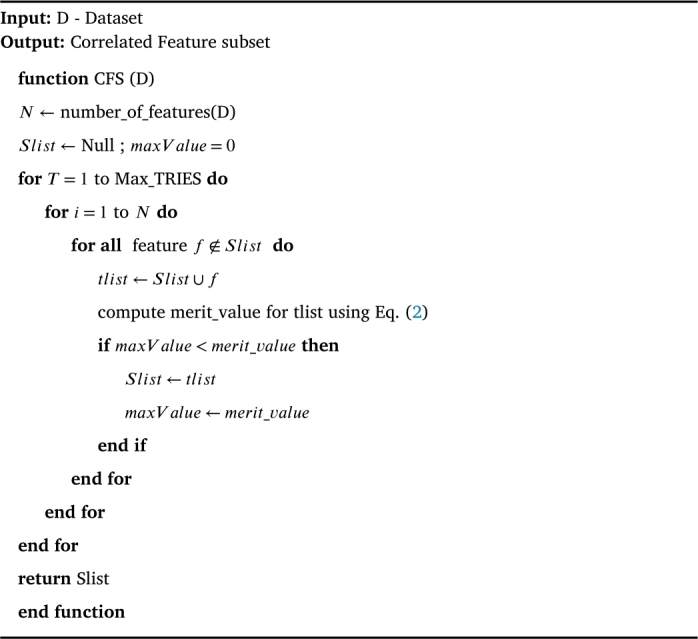
CFS Algorithm [30].